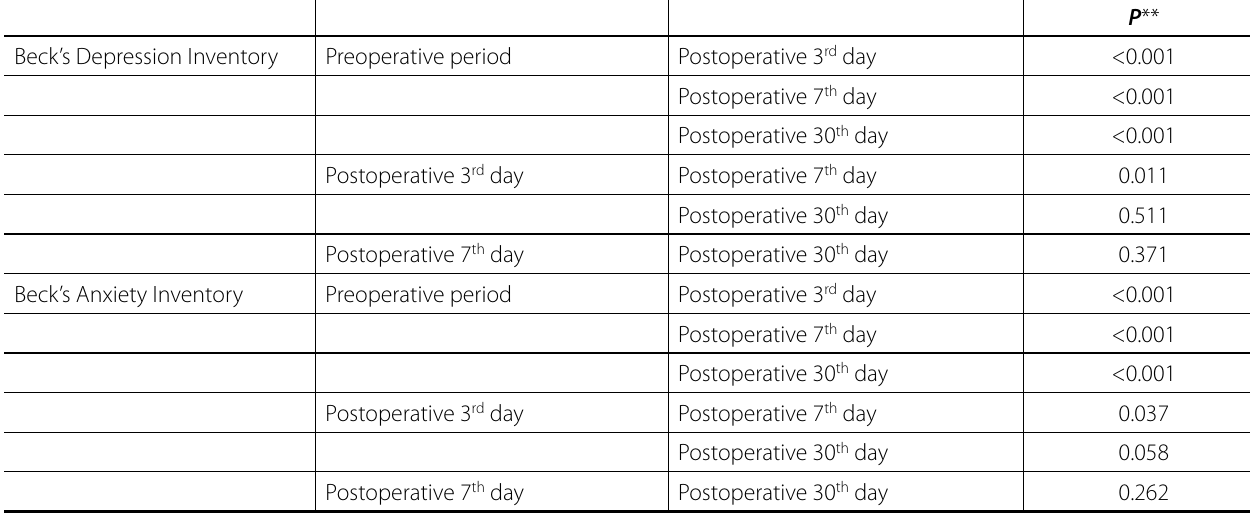
Table 3 . Subgroup analysis: both anxiety and depression levels increased on postoperative 3 rd , 7 th , and 30 th days compared with preoperative test results ( P